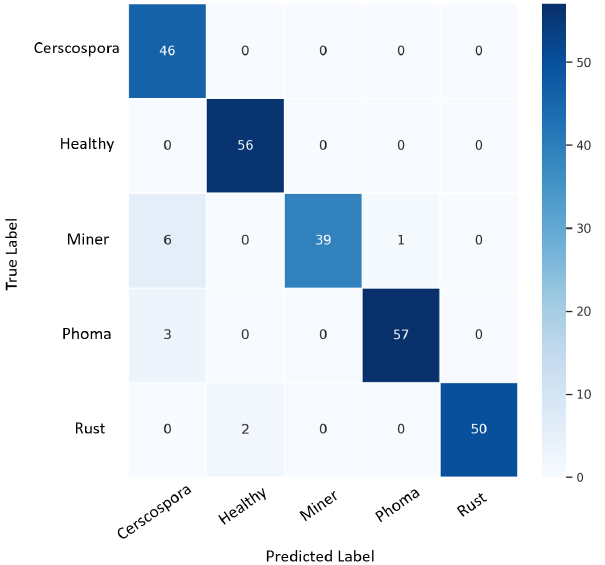
Figure 6. Confusion matrix of the ensemble model.